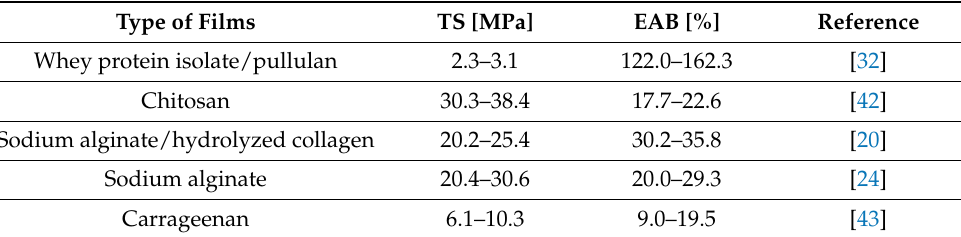
Table 3. Influence of SiO 2 additive on mechanical properties (tensile strength ‐ TS and elongation at break ‐ EAB) of selected biopolymer films.